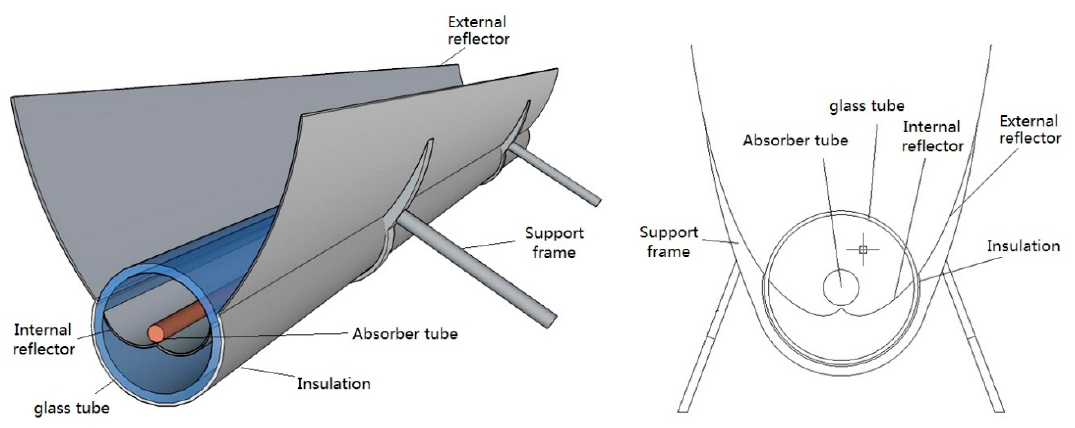
Figure 17. Schematic diagram of internal and external concentrating combined CPC (left: 3-D model, right: Cross-sectional view) [38].